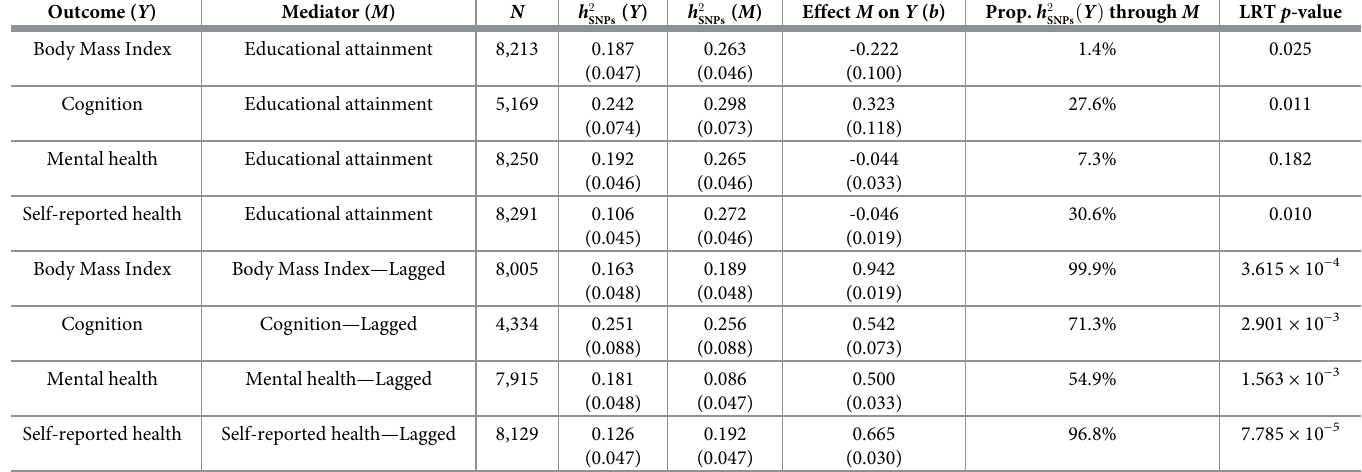
Table 4. MA-GREML results for the empirical analyses using data from the Health and Retirement Study. LRT = Likelihood-Ratio Test for significance of indirect effect ( a 2 + g 2 ) b 2 (i.e., the proportion of h 2 of outcome Y running through mediator M ); Standard errors in SNPs